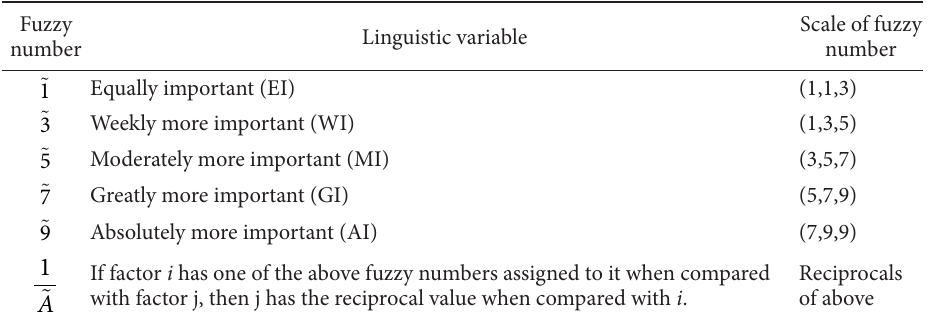
Linguistic variable